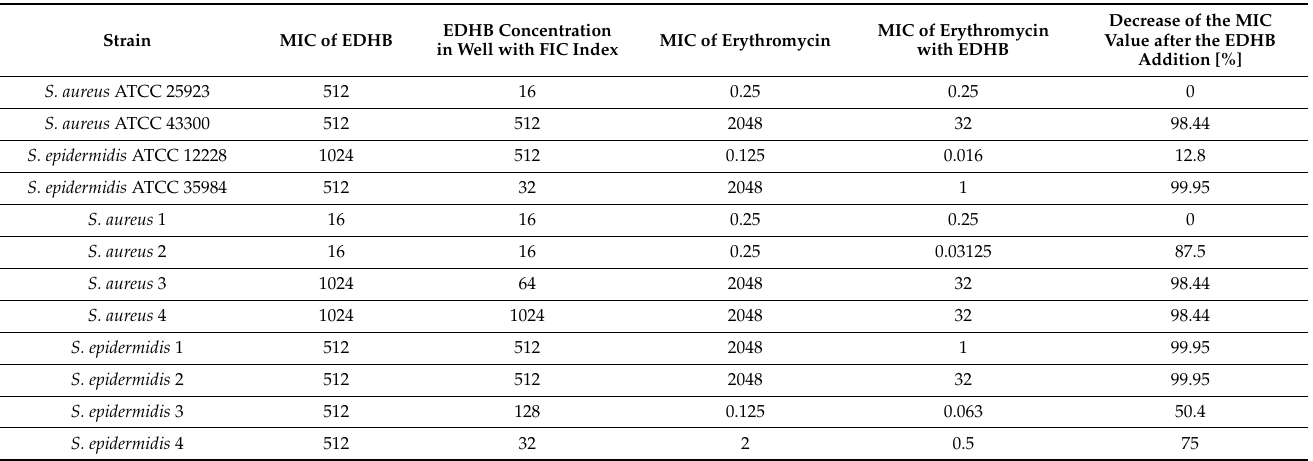
Table 4. The MIC values of erythromycin alone and in combination with EDHB towards staphylococ- cal